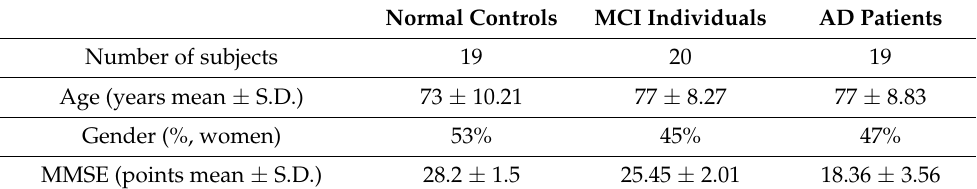
Table 2. Patient demographic and clinical characteristics related to peripheral blood samples (PBMCs). Normal